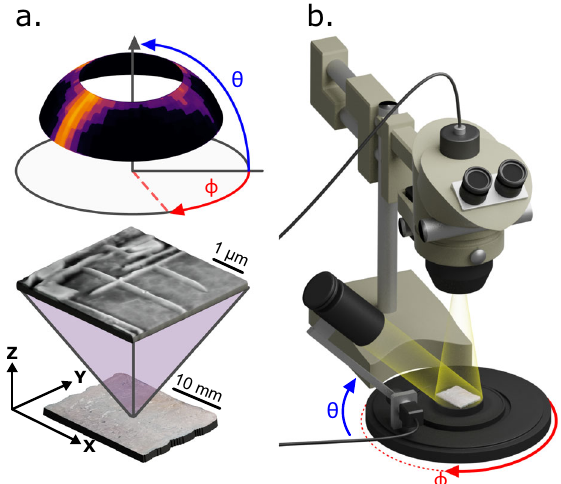
Fig. 1 Illustration of the DRM technique. a In I718, chemical etching reveals δ phase precipitates in the form of elongated platelets protruding on the surface (here, seen under the scanning electron microscope). These platelets are in a speci fi c crystal- lographic relationship with the γ matrix, causing surface re fl ectance to vary with grain orientation and the incident illumination angle. b The DRM apparatus (here, represented schematically) consists of a stereomicroscope focused on a fi xed specimen and a moving white light source. A sequence of micrographs is captured while the light source rotates around the